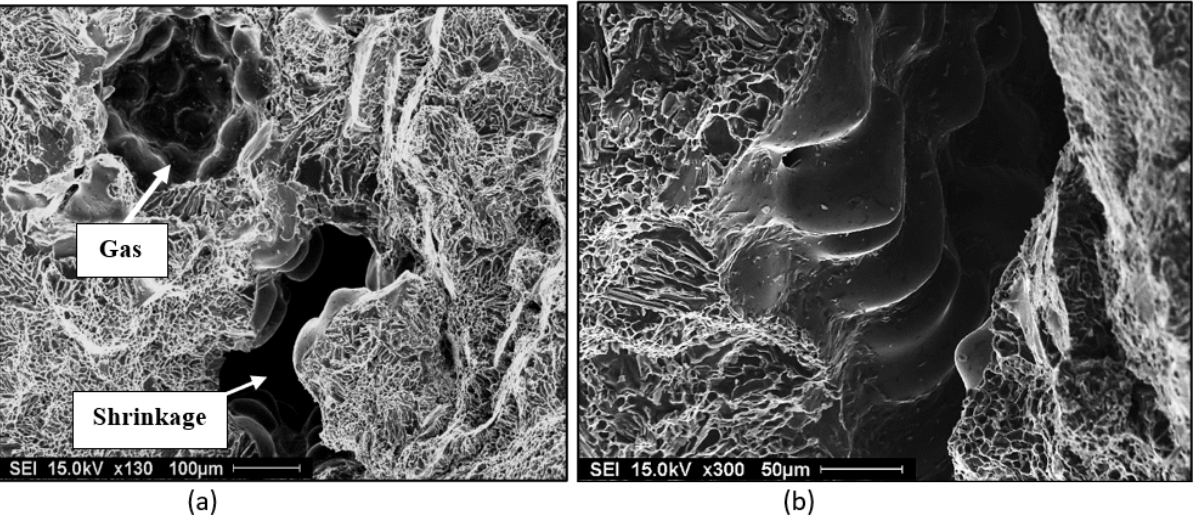
Figure 1. SEM electron images of porosity in 319 alloy ( a ) a mixture of gas and shrinkage, ( b ) a high magnification micrograph of shrinkage reveals dendrites.